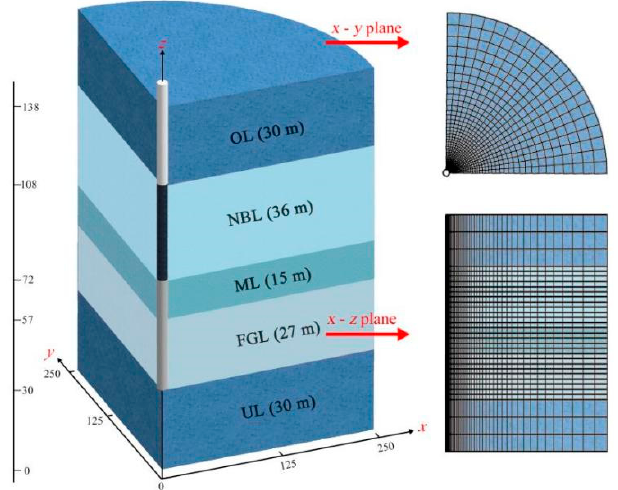
Figure 7. Simplified numerical simulation system and the mesh distribution.